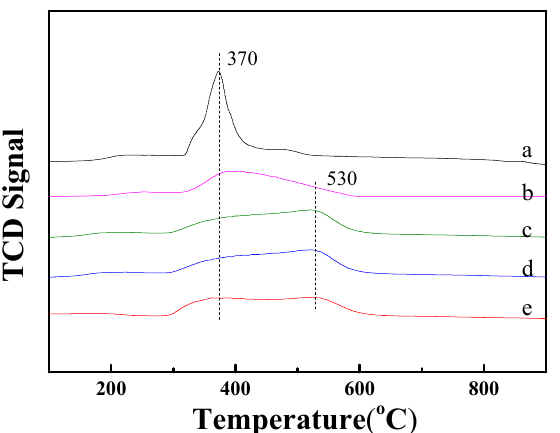
Figure 4. H 2 -TPR profiles of the as-prepared Ni/SiO 2 ( a ), Ni-G-2/SiO 2 -C ( b ), Ni-G-1/SiO 2 -P ( c ), Ni-G-2/SiO 2 -P ( d ), and Ni-G-3/SiO 2 -P ( e ) catalysts.